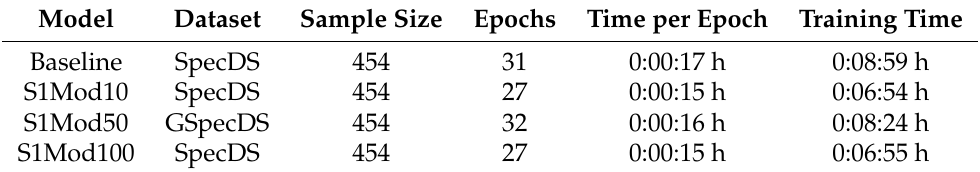
Table 3. Training stage